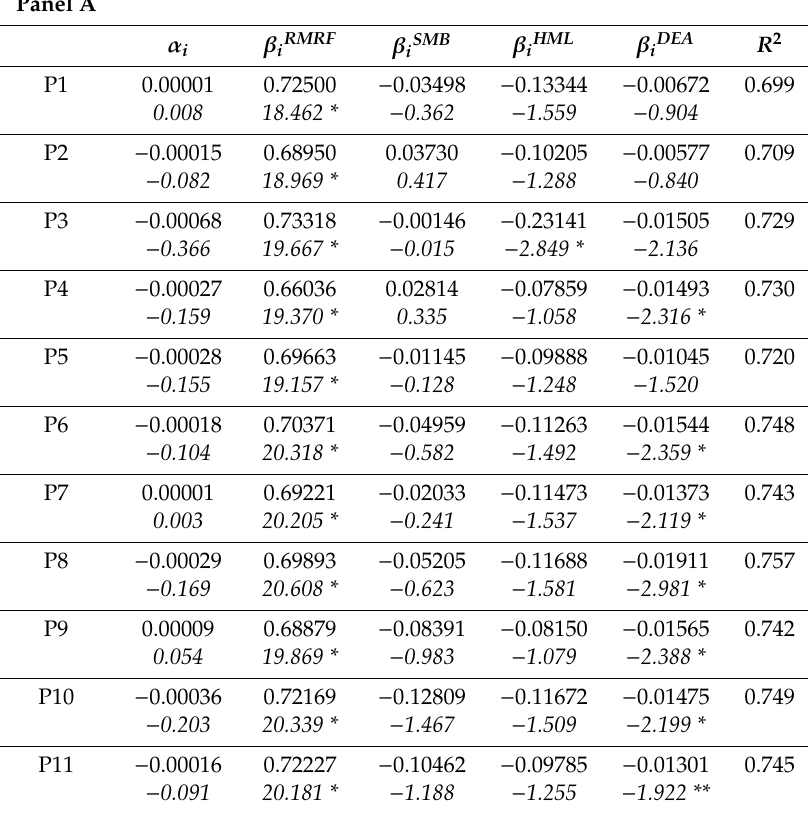
Table A1. Time-series regression results for the four-factor model 1